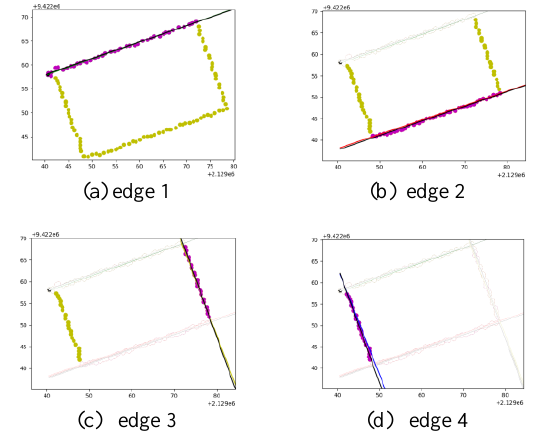
Figure 5. Adaptive RanSAC procedure for a simple roof